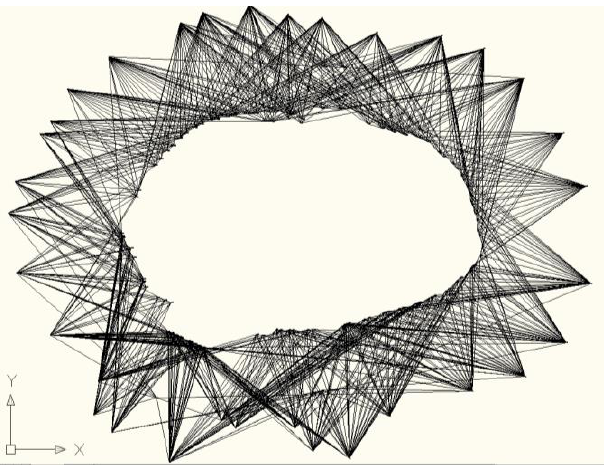
Figure 29 – The lay-out of the 36 panoramas around the